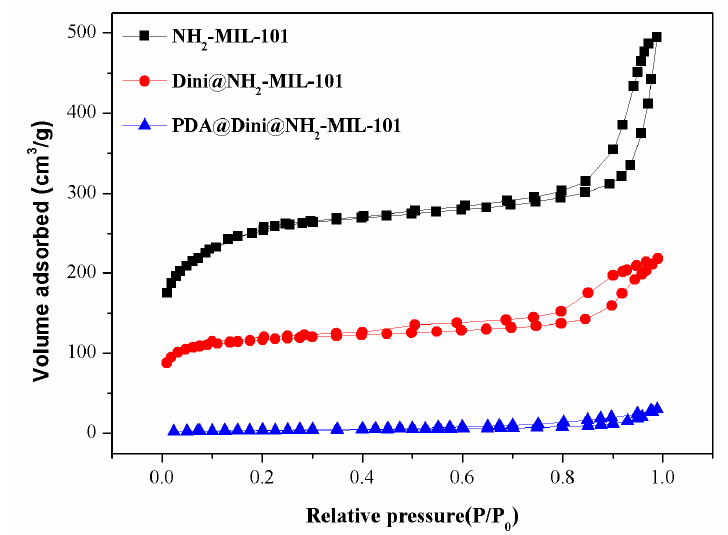
Figure 6. Nitrogen adsorption–desorption isotherms of NH 2 -Fe-MIL-101, Dini@NH 2 -Fe-MIL-101 and